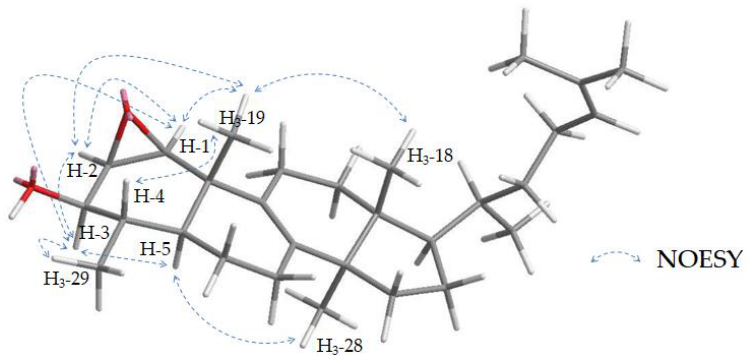
Figure 11. Key NOESY signals of 24 for determination of the relative configuration in the A ring.